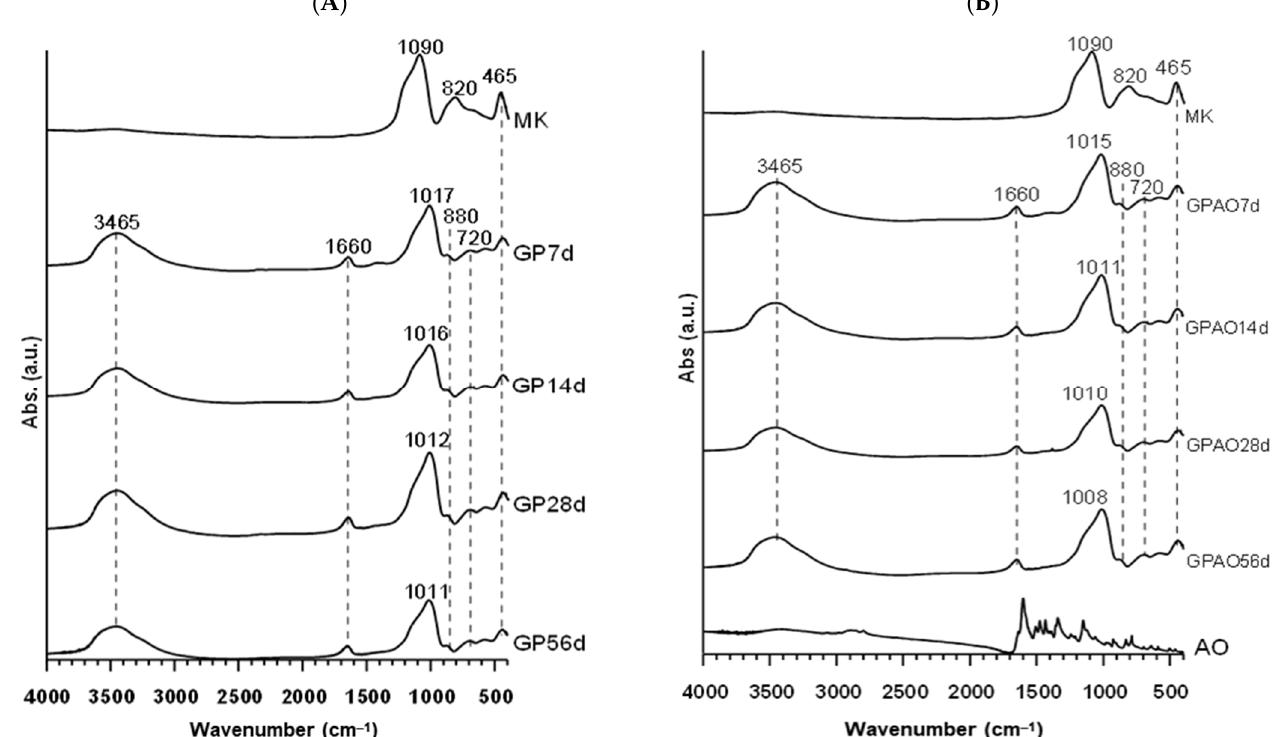
Figure 3. ( A ) FT-IR spectra of MK and GP at different ageing times. ( B ) FT-IR spectra of MK, AO, and GPAO at different ageing times.